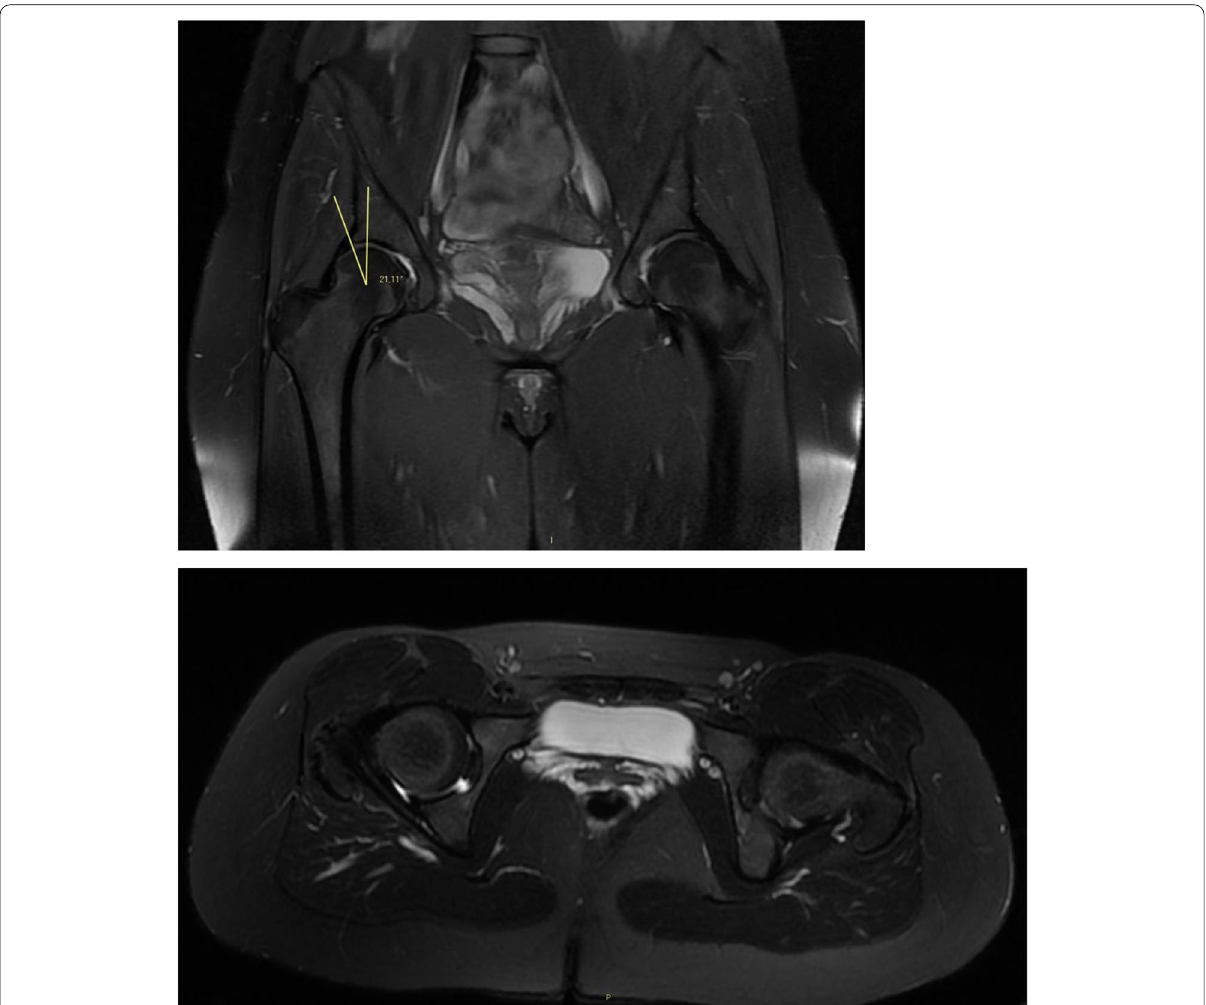
Fig. 2 MRI evaluation of a group A patient: Coronal and Axial MRI view of the previous 22 years old female showing no chondral damage and mild dysplasia of the right hip